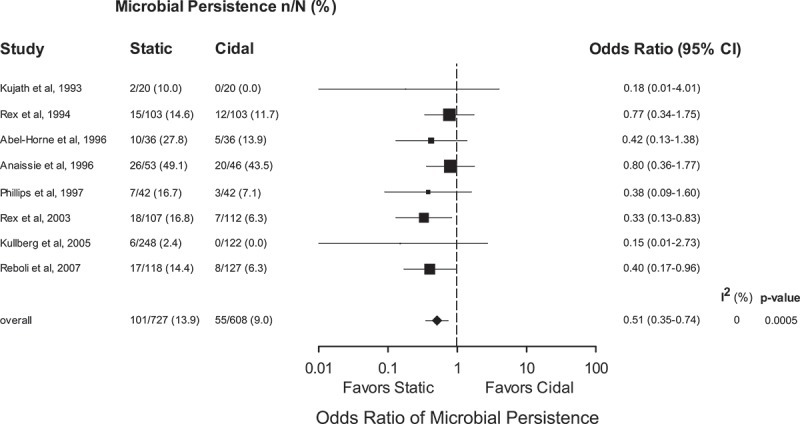
Microbial persistence following therapy for trials comparing fungicidal and fungistatic therapy of invasive candidiasis and/or candidemia. Odds ratios (ORs) are pooled using a random-effects model on a logarithmic scale. The size of the squares is proportional to the reciprocal of the variance of the studies. CI: confidence interval, n/N: frequency of finding.